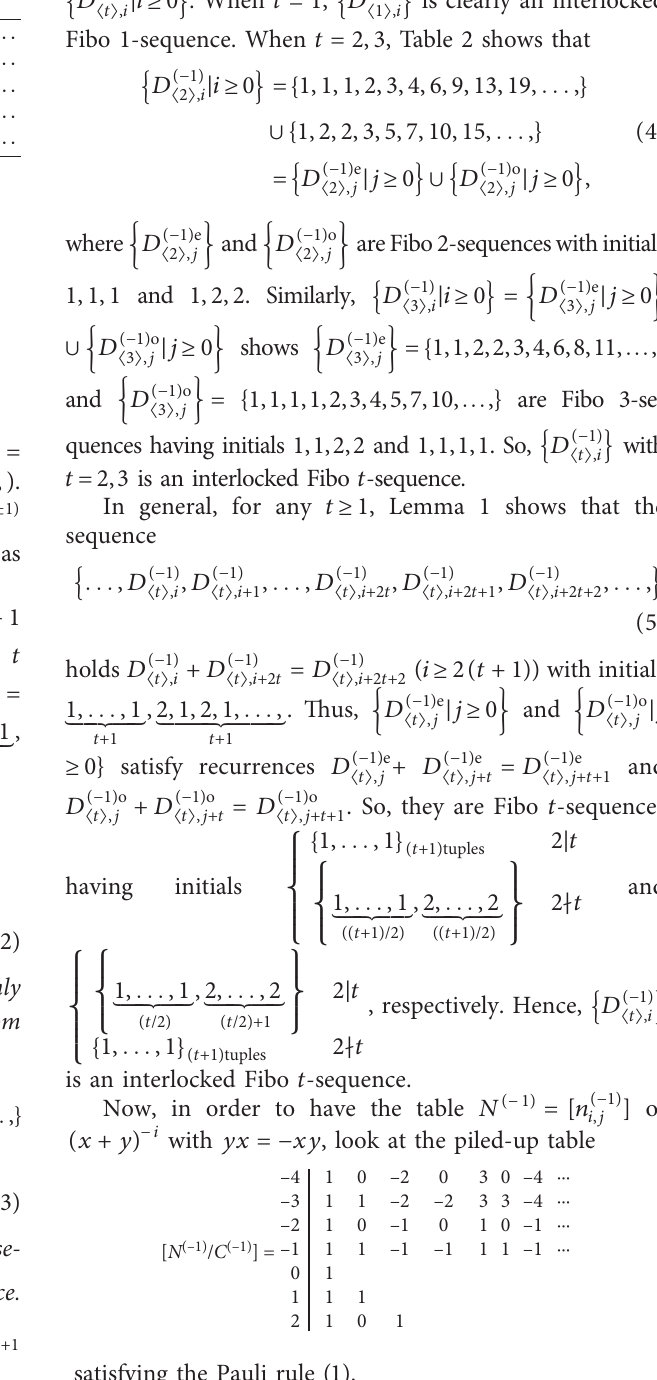
Table 1: N ( 1 ) � [ n ( 1 )